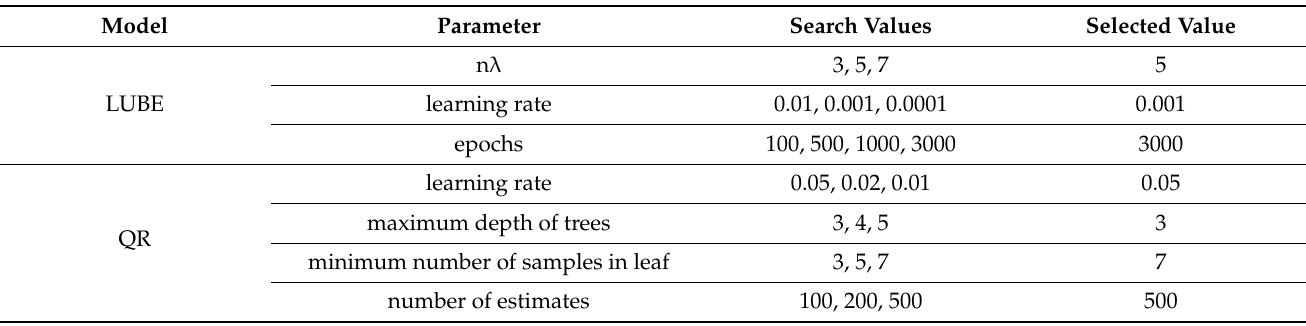
Table 1. Grid search for neural network and quantile